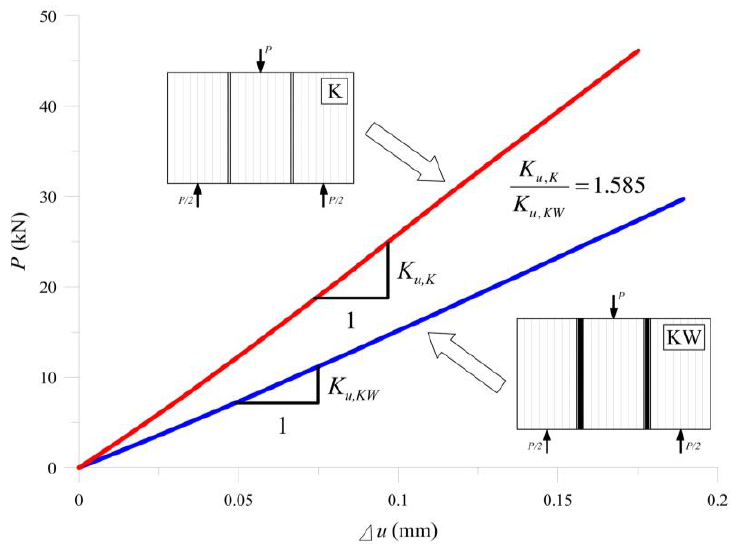
Figure 13. Sti ff ness measurement results for the samples “K” and Figure 13. Stiffness measurement results for the samples “K” and “KW”.